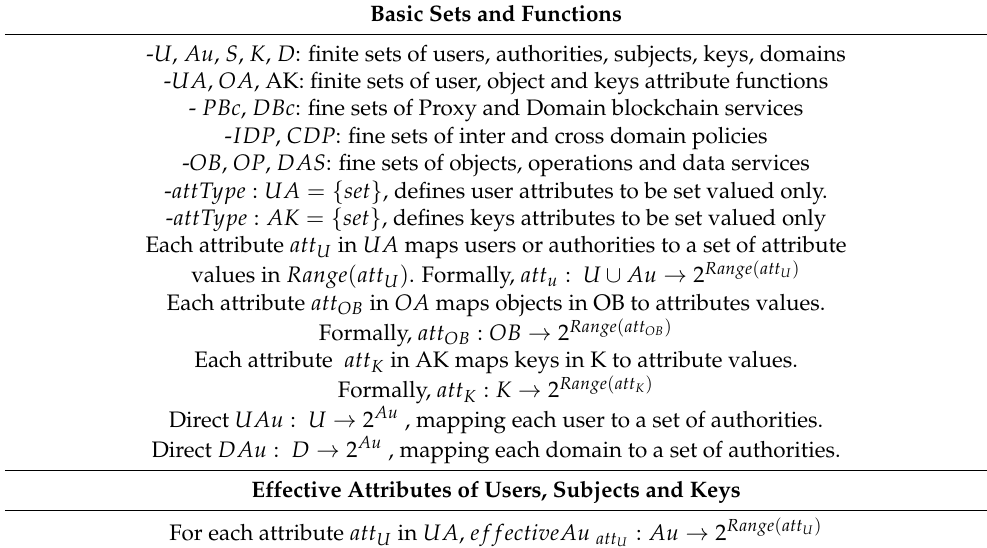
Table 2. Basic sets and functions of the HMBAC model. Basic Sets and